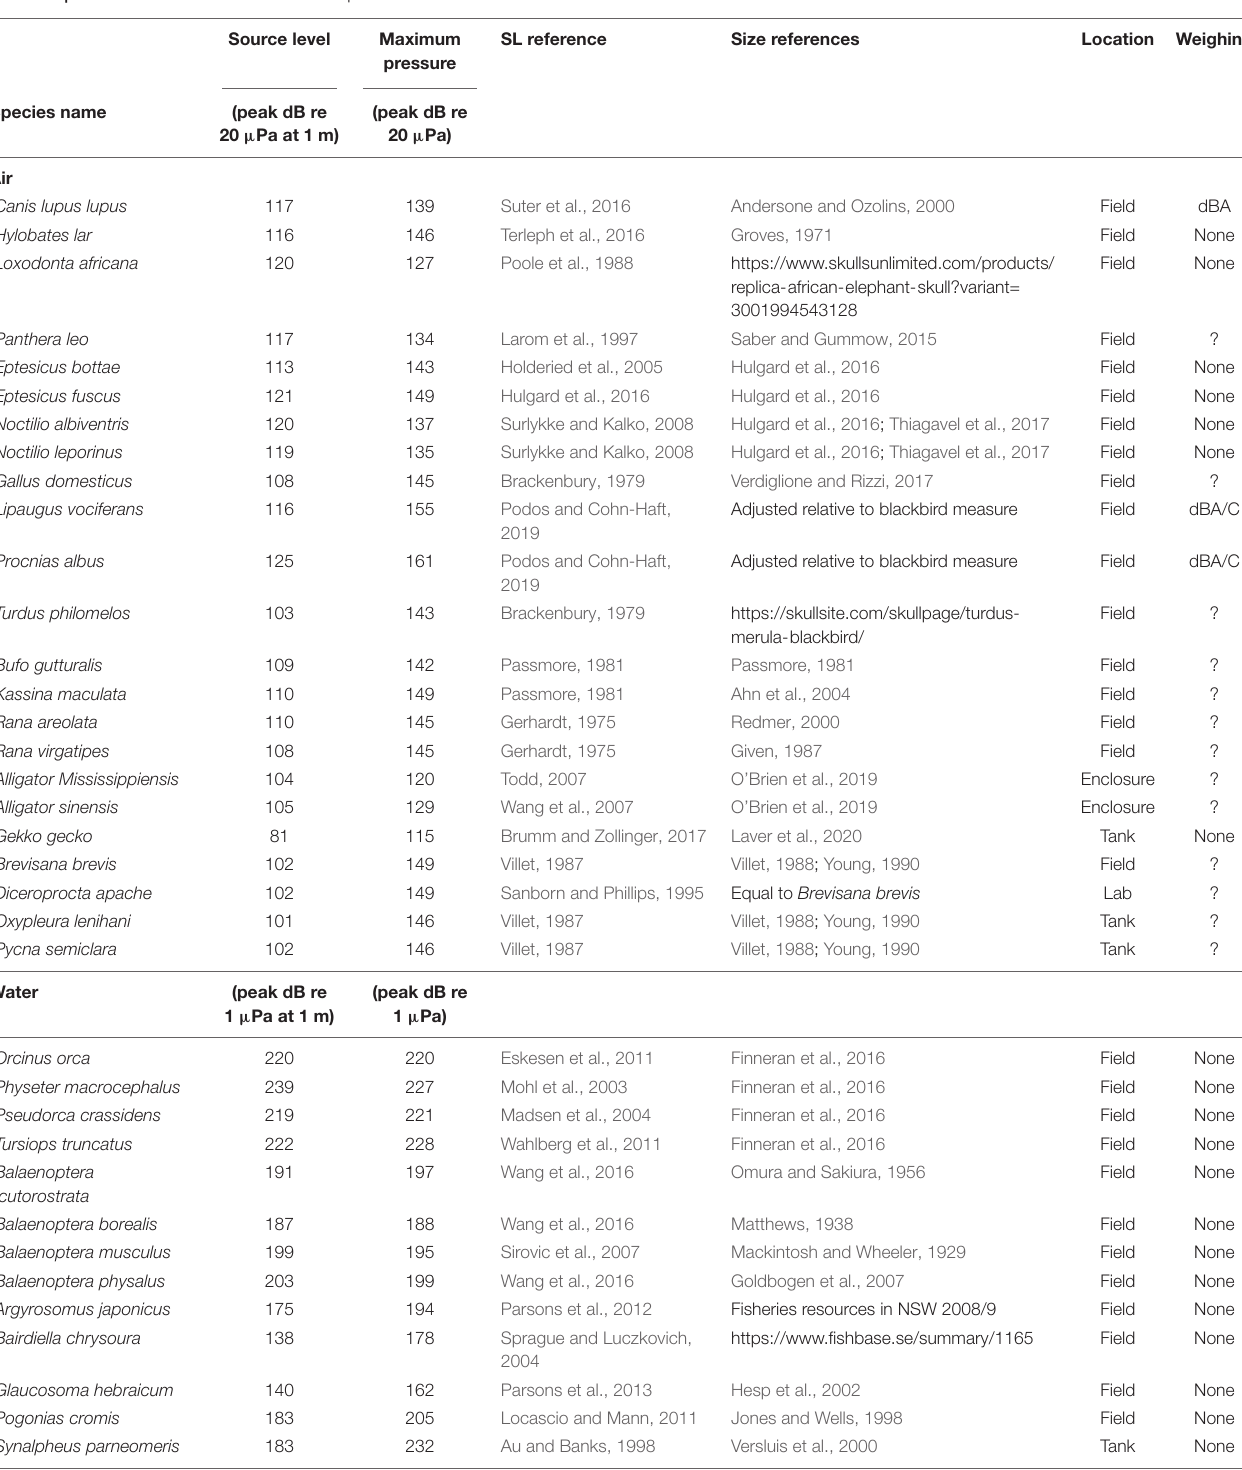
TABLE 1 | Source level and maximum radiated pressures for animals in air and